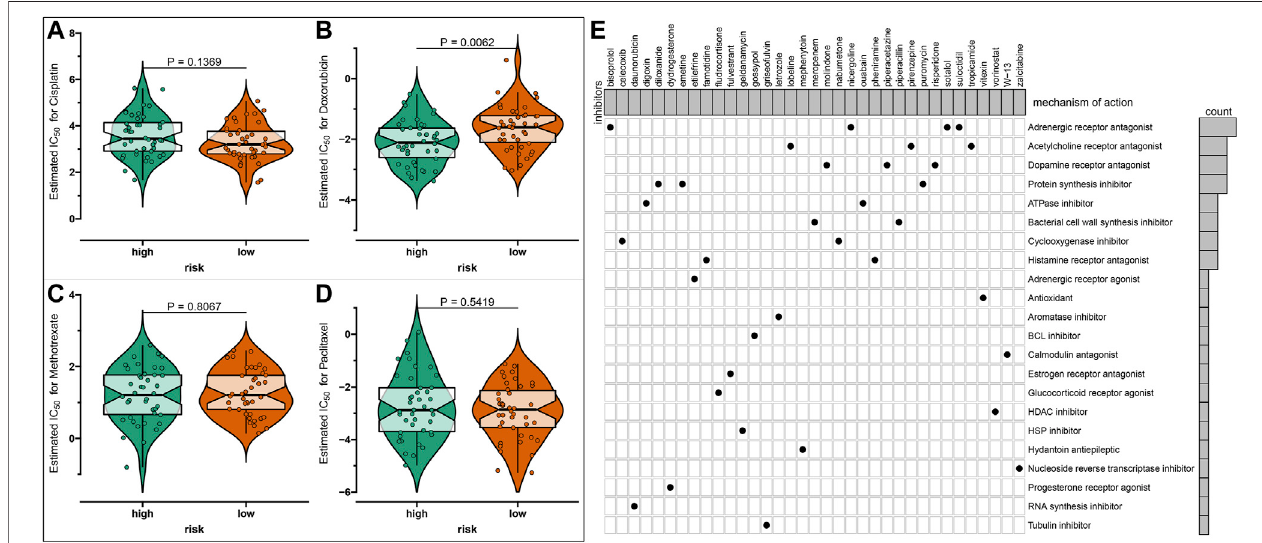
FIGURE 4 | Prediction of chemotherapy drug sensitivity and potential small molecule compounds based on risk scores in osteosarcoma. (A – D) Drug sensitivity of (A) paclitaxel, (B) methotrexate, (C) doxorubicin, and (D) cisplatin between high- and low-risk osteosarcoma samples by the Genomics of Drug Sensitivity in Cancer (GDSC) database. (E) The shared mechanism of action among small molecule